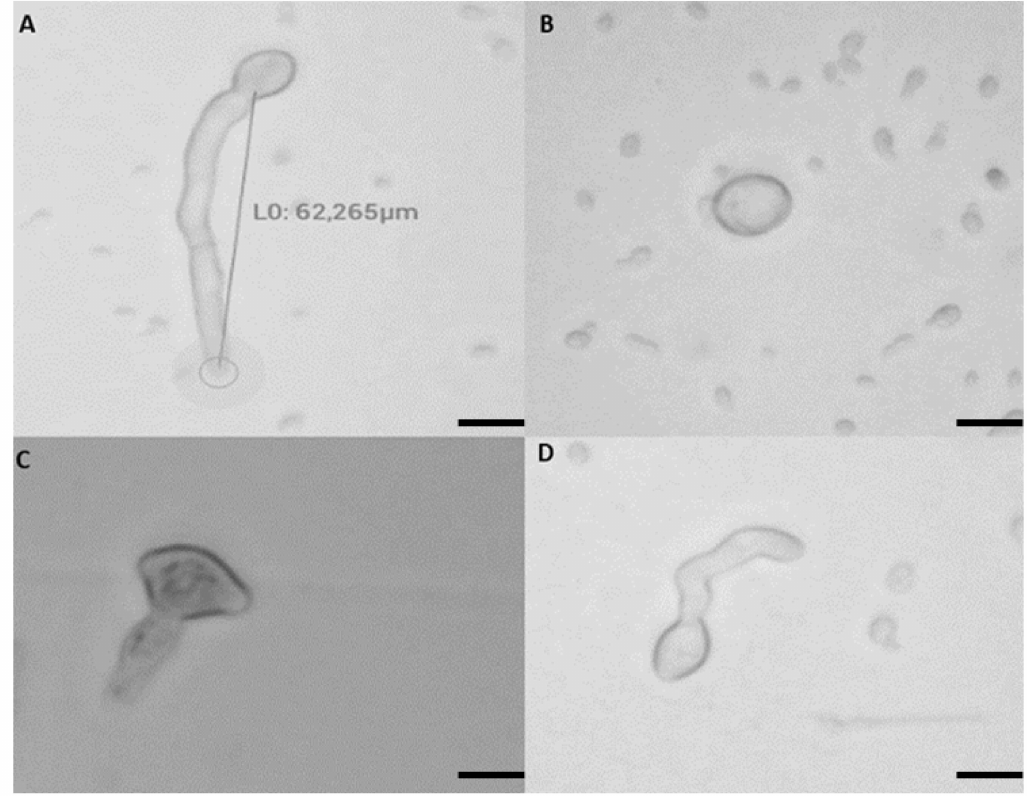
Figure 3. Microscopic observations of spores of Monilinia fructigena species after 24 h of incubation at 25 ◦ C with agitation according to treatments. Normal and germinated spore in the untreated control ( A ). Non-germinated spores in 5% SBC + ACBC1 treatment ( B ). Altered spore with the appearance of germ tube in 3.5% SBC + SF14 treatment ( C ). Normal spore and appearance of germ tube in 5% SBC treatment ( D ). Bars = 10 µ